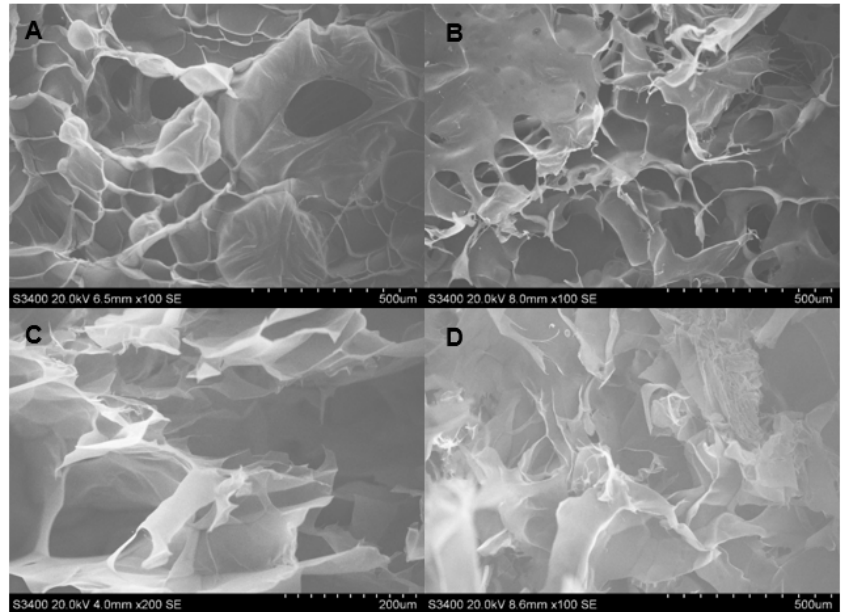
Figure 2. SEM images of hydrogel porous scaffolds made from solution of ( A ) 9:1 gelatin/SCMC solution (100×); ( B ) 9:1 gelatin/SCMC solution and 2% glutaraldehyde (100×); ( C ) 9:1 gelatin/SCMC solution and DOX (100×) and ( D ) 9:1 gelatin/SCMC solution, DOX, and 2% glutaraldehyde (100×).